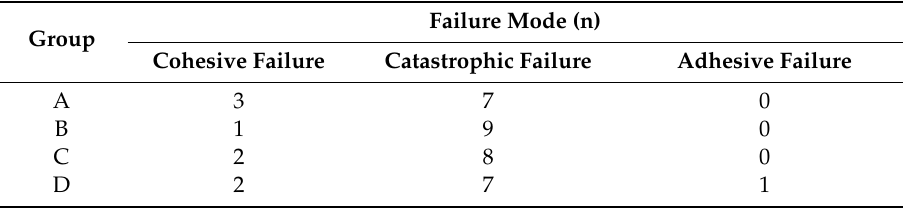
Table 6. Mode of failure of repaired veneered zirconia